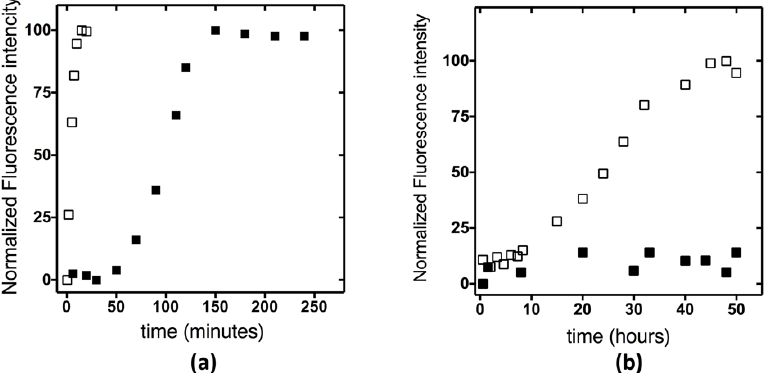
Figure 5. Kinetics of fibril formation followed by ThT fluorescence analysis at 482 nm ( λ ex = 440 nm) of KH0 (full squares) and R138Q (empty squares) incubated at 55 °C ( a ) and 37 °C ( b ) in 20 mM sodium phosphate pH 7.2, 100 mM NaCl.